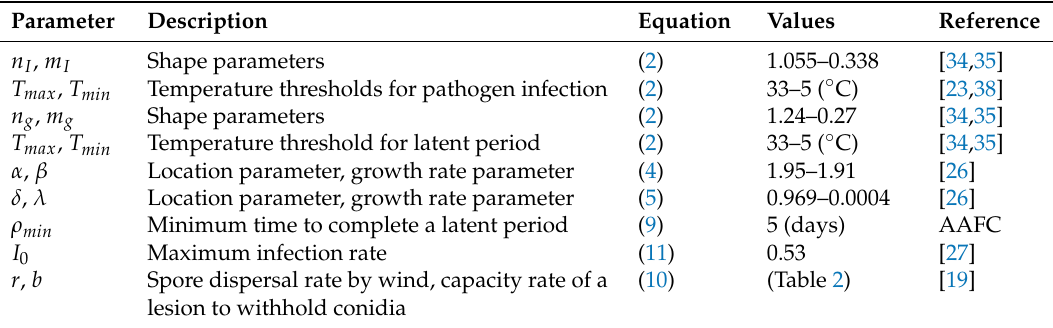
Table 1. Calibrated, site-specific parameter values for PM